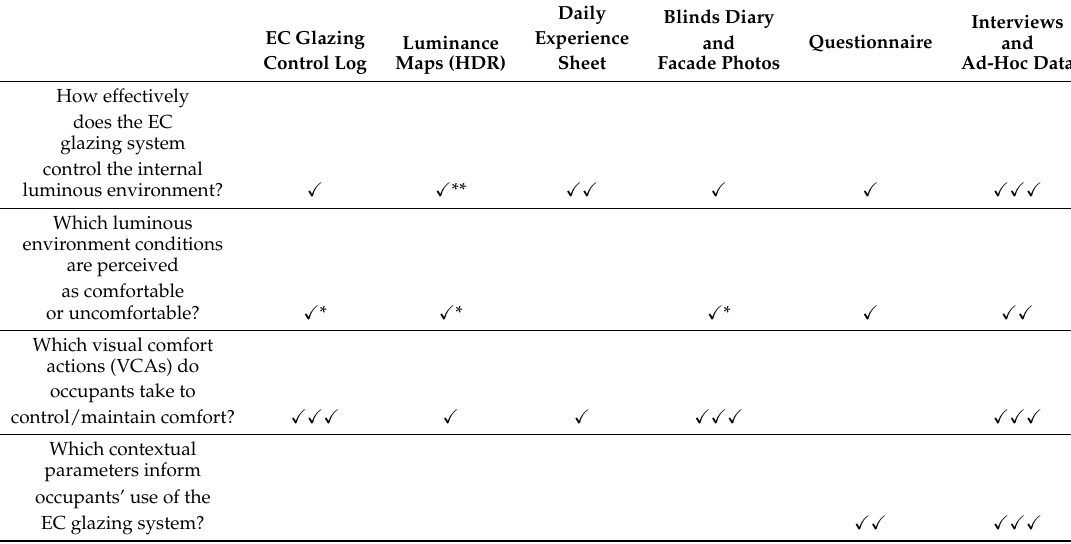
Table 4. Mapping data sources with research questions. Number of (cid:88) indicates weight of contribution; * Denotes indirect contribution: occurrence of visual comfort actions (VCAs); ** Denotes indirect contribution: internal conditions before and after